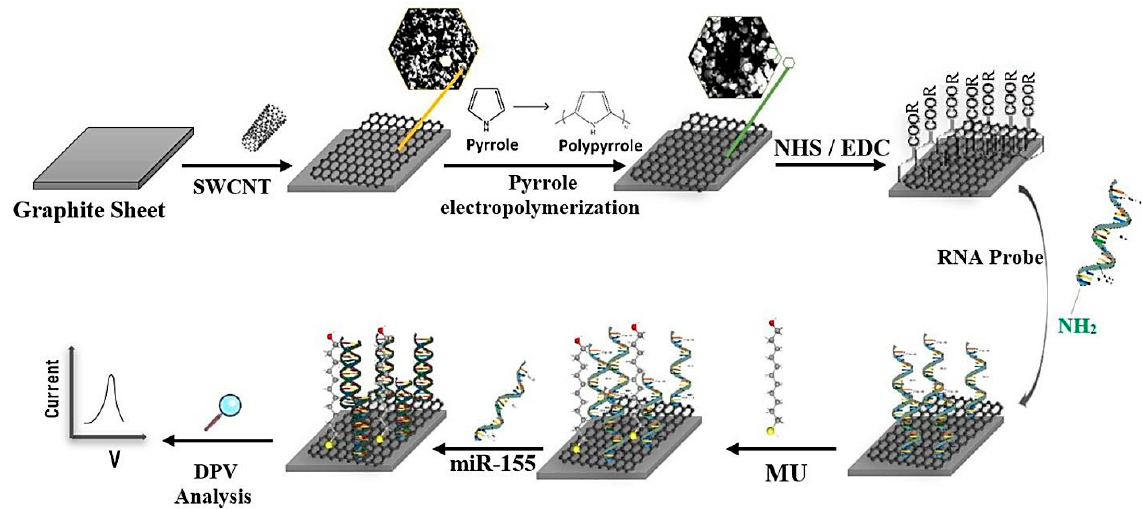
Figure 6. Schematic representation of an electrochemical aptasensor based on the SWCNTs/PPY for miR-155. Reprinted from [46], with permission.